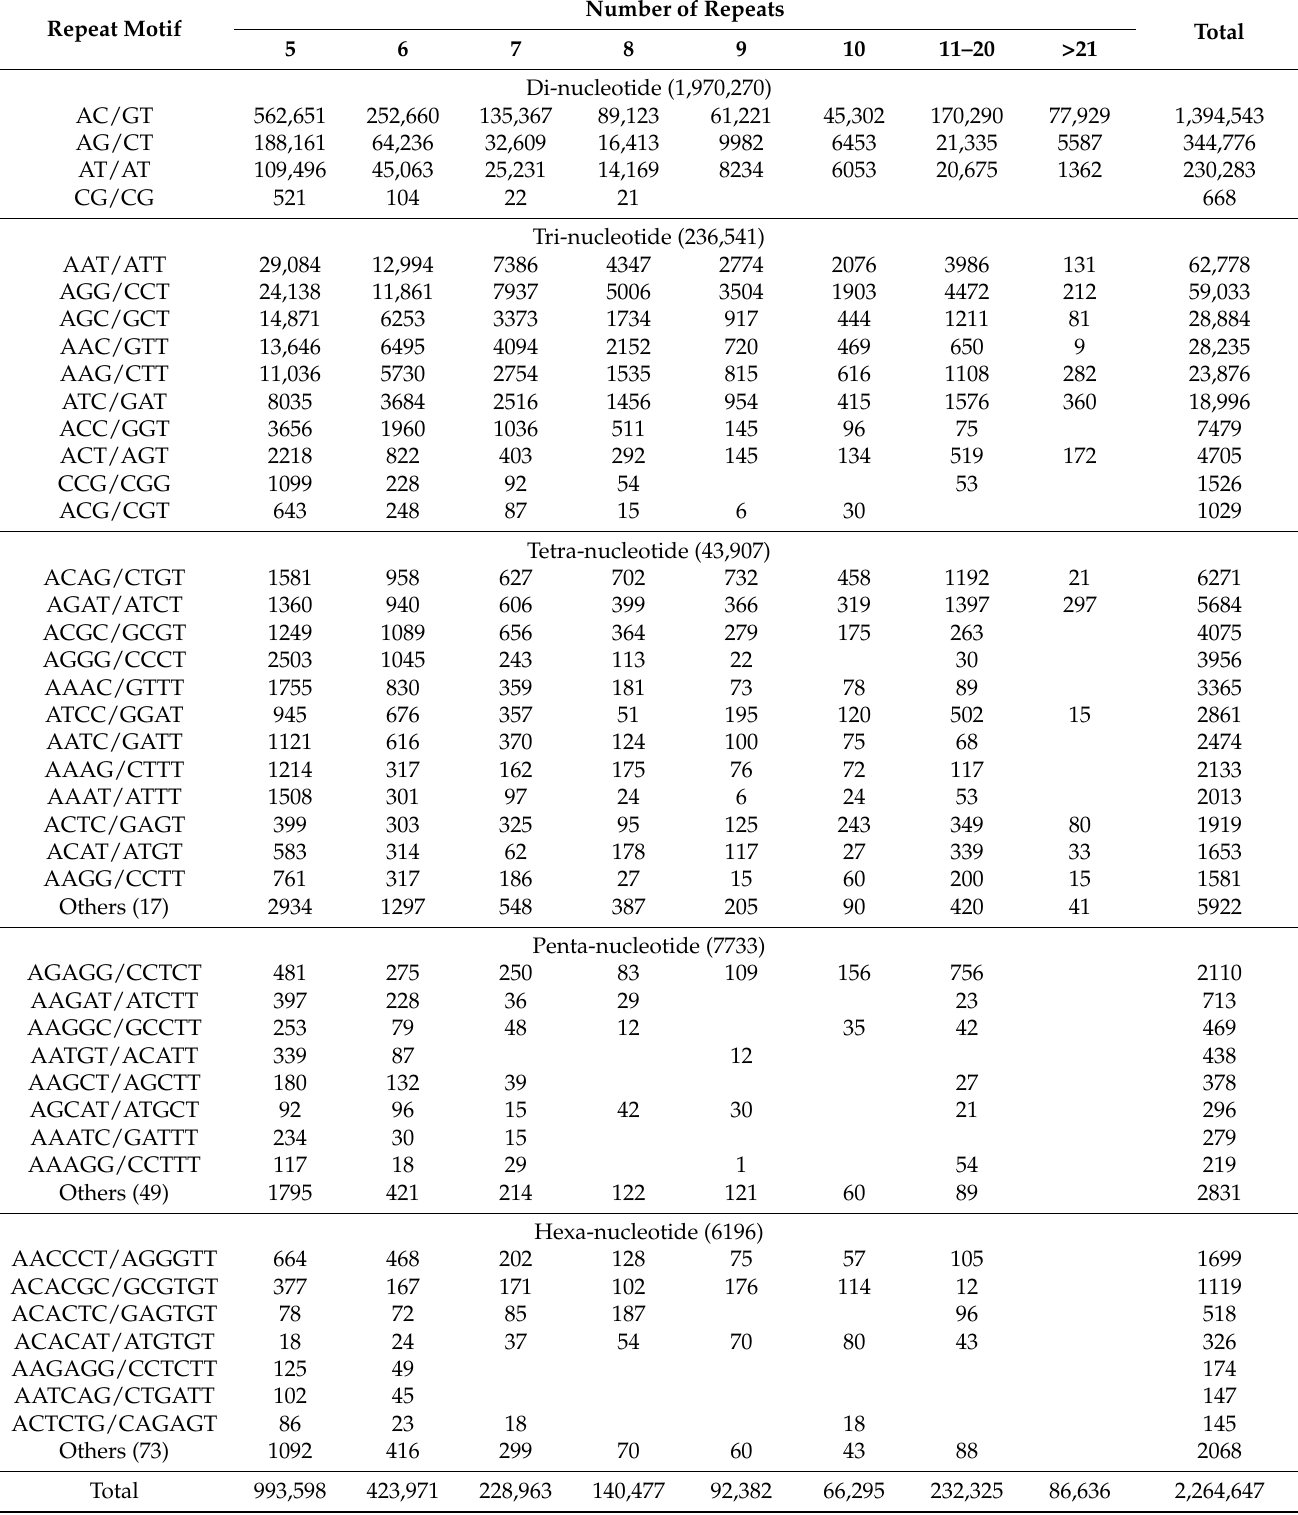
Table 4. Distribution of microsatellite motifs in T. loennbergii